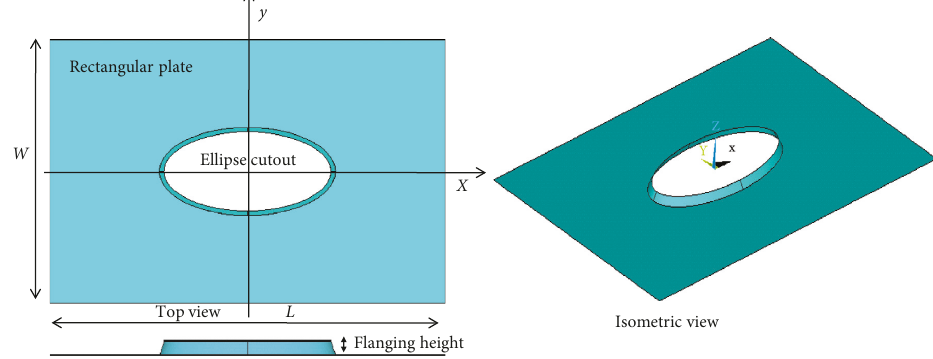
Figure 1: A rectangular plate with a central flanging ellipse